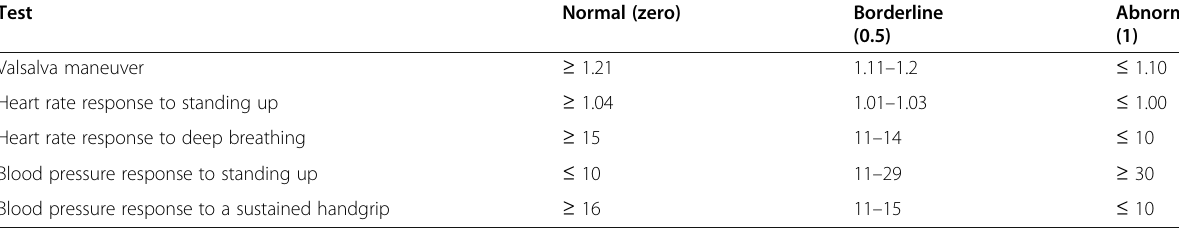
Table 1 Cut off values for the results of the cardiovascular autonomic reflex